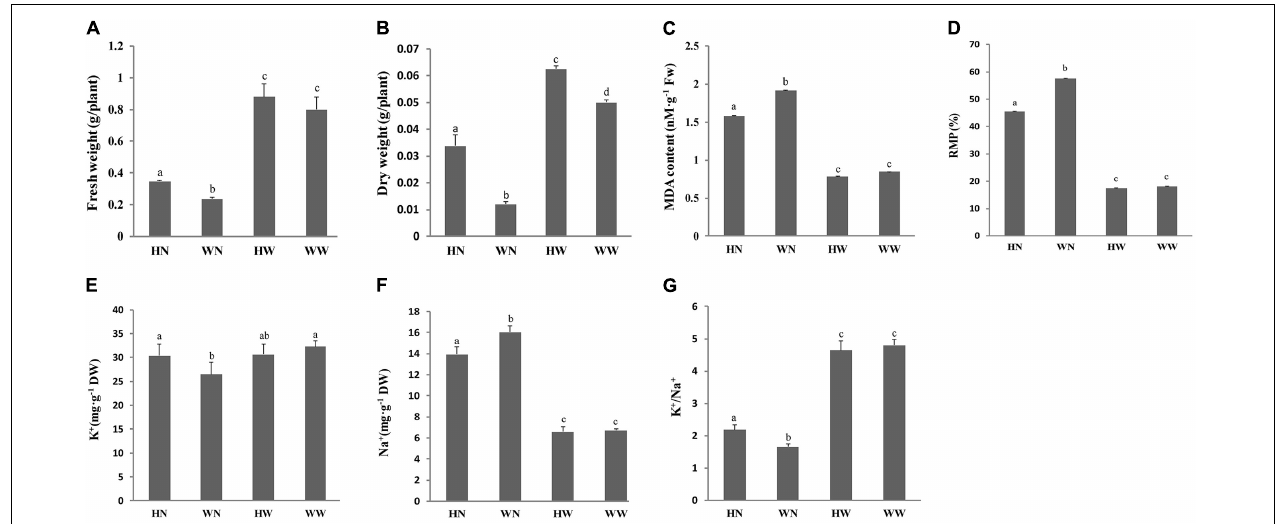
FIGURE 1 | Physiological response of Arabidopsis seedlings to salt stress after H 2 O 2 pretreatment. The influence of H 2 O 2 pretreatment on the aerial fresh weight (A) and dry weight (B) of Arabidopsis seedlings under different treatments; the impact of H 2 O 2 pretreatment on MDA content (C) and RMP (D) of Arabidopsis leaves under different treatments; and the impact of H 2 O 2 pretreatment on K + (E) and Na + (F) content and K + /Na + (G) in leaves of Arabidopsis seedlings under different treatments. Data are represented as means ± SD. Three biological replicates per experiment. Means for each treatment that do not share a common letter are significantly different at P < 0.05, estimated with one-way ANOVA following SPSS. WW, pretreated with water and not salt-stressed; WN, pretreated with water and salt-stressed; HW, pretreated with H 2 O 2 and not salt-stressed; HN, pretreated with H 2 O 2 and